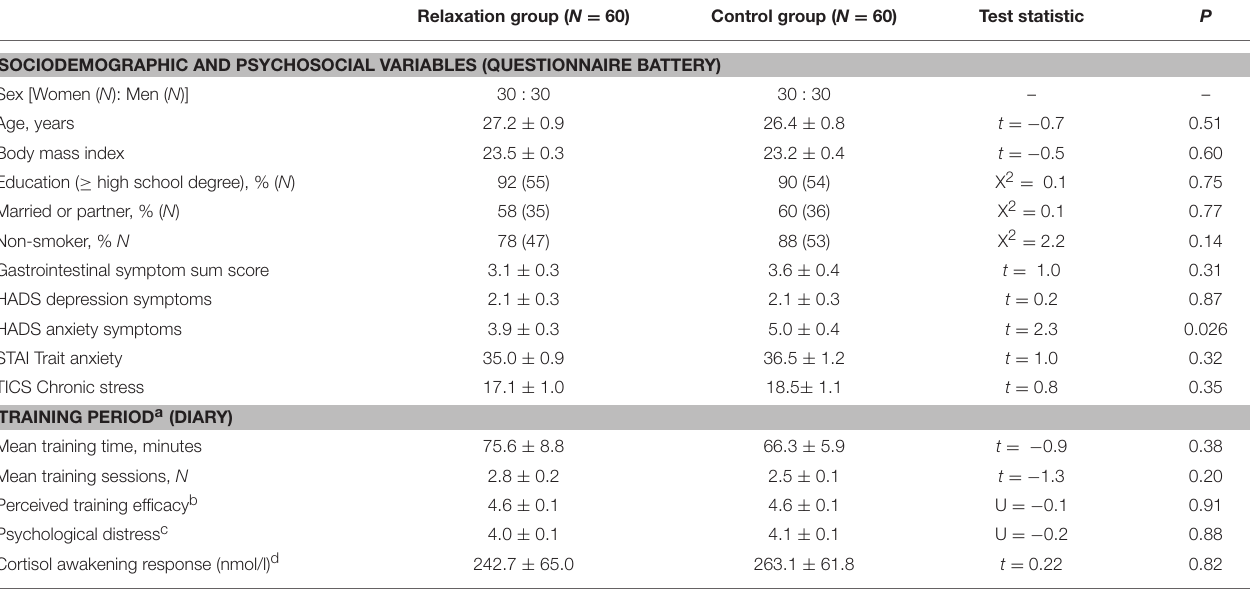
TABLE 1 | Sample characteristics and measures collected during training. Relaxation group ( N = 60) Control group ( N = 60) Test statistic